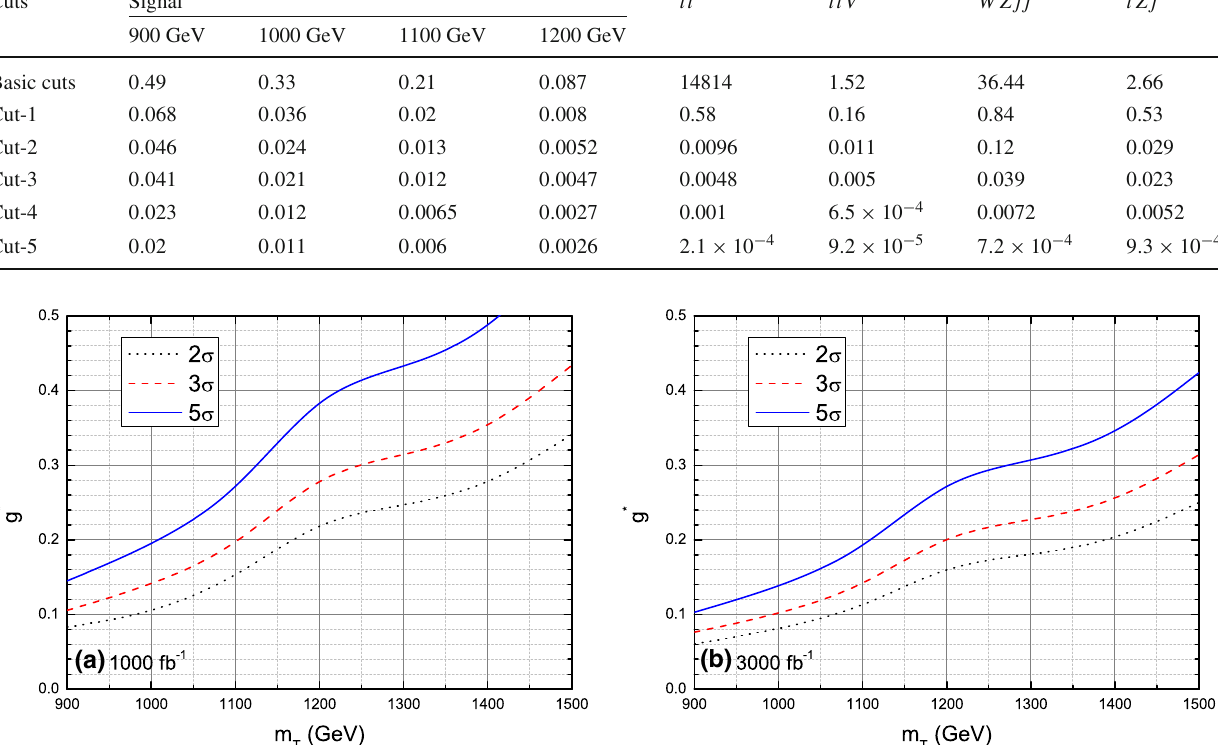
Fig. 9 The 2 σ , 3 σ and 5 σ contour plots for the signal in g ∗ − m T at 14 TeV LHC with two typical values of integrated luminosity: a 1000fb − 1 ,